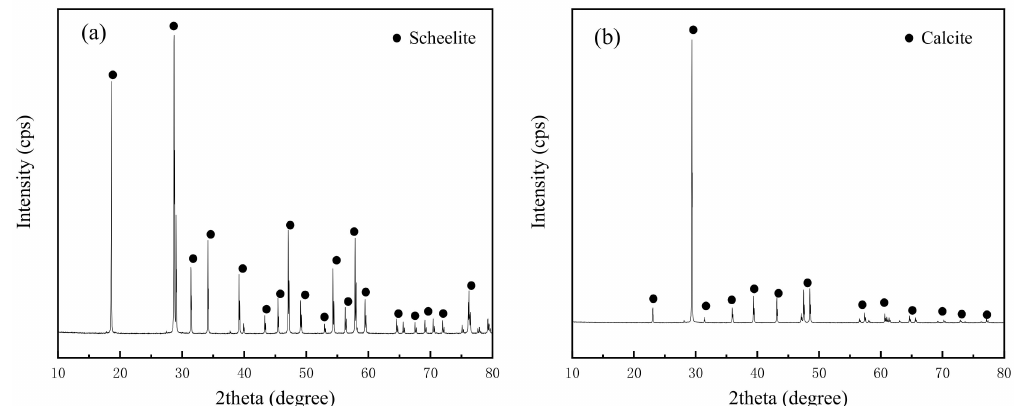
Figure 2. XRD spectra of scheecite ( a ) and calcite ( b ) samples.